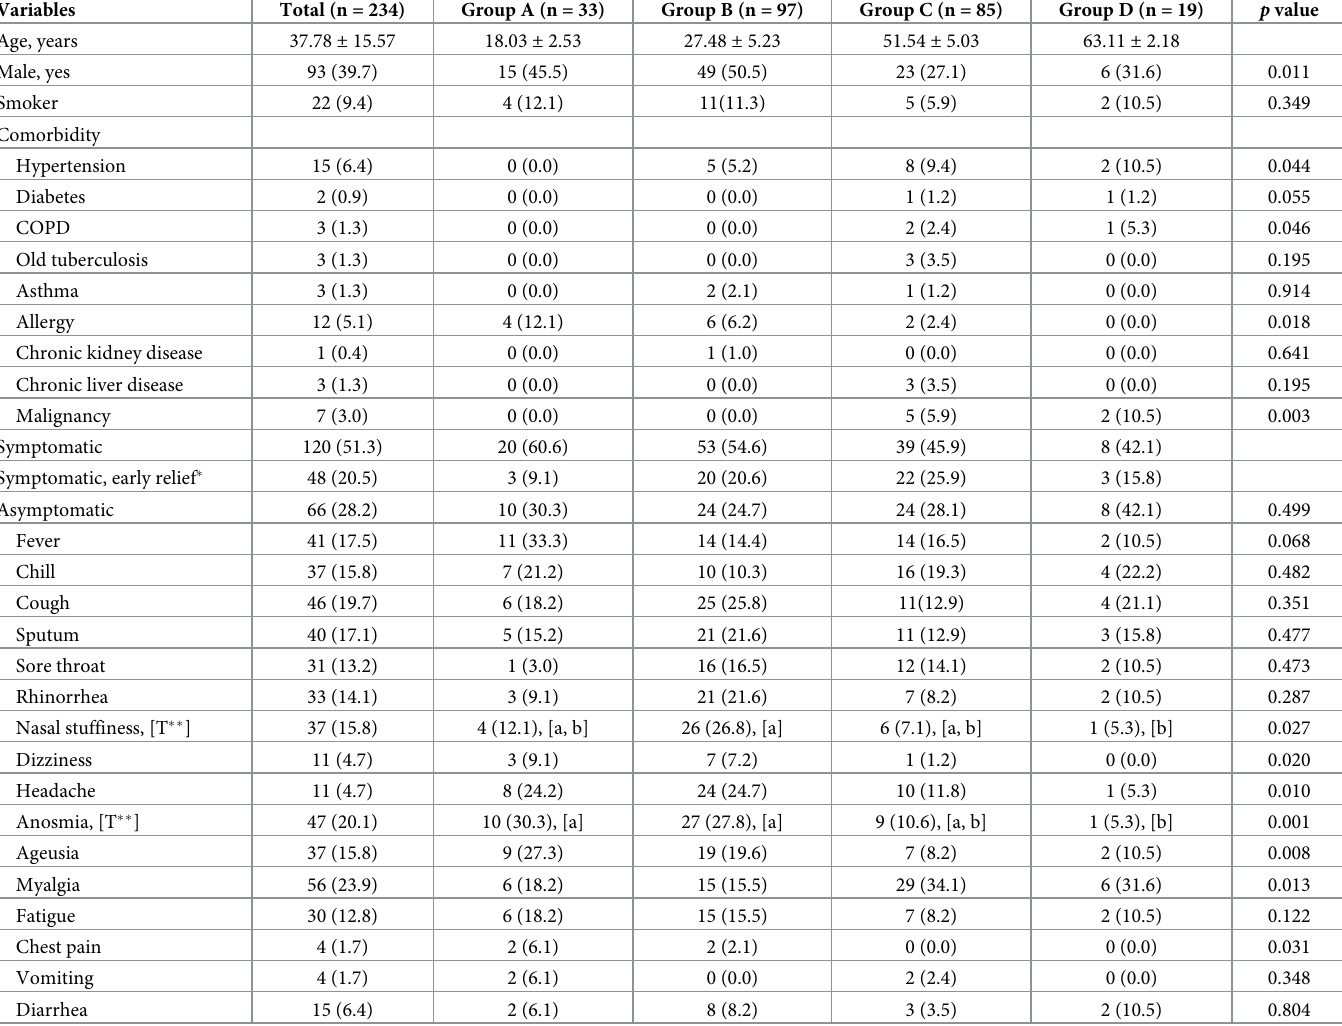
Table 1. Comparisons of demographic and clinical characteristics according to stratified age groups in asymptomatic or mildly symptomatic patients with